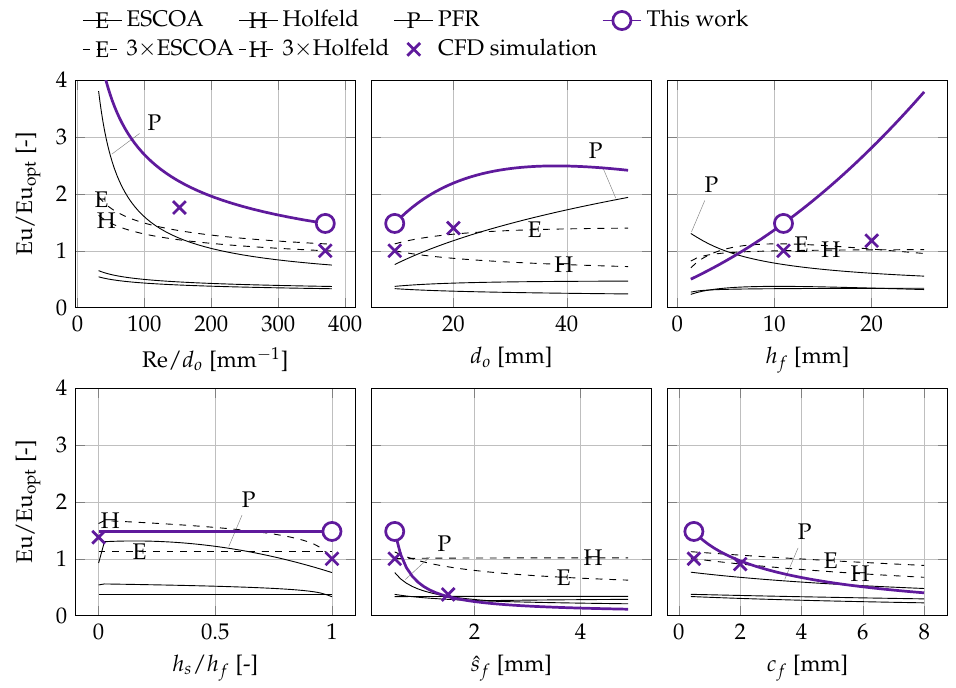
Figure 7. Trends in correlations around the case study optimum found using correlations developed in this work (marked by a circle). CFD simulations were independently sampled (not part of the dataset used for model development). Each parameter was varied independently, with remaining parameters held constant at the